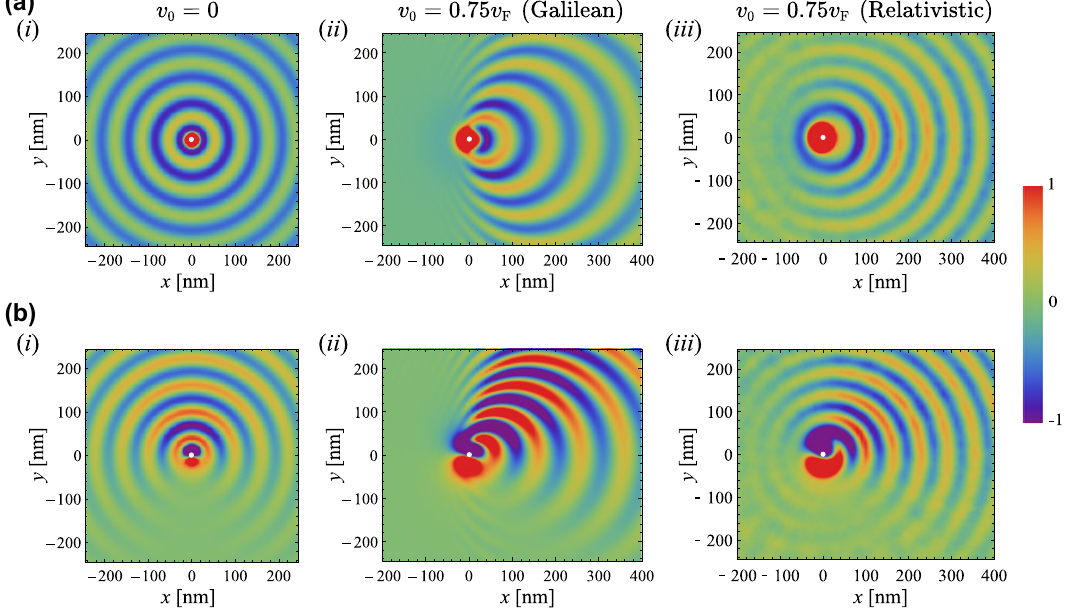
= 4. (a–b) Time r , s (in arbitrary unities)calculated on the surface of the graphene sheet for an electric dipole ( ) z ̂ z (C m); (b) Circularly polarized dipole with p ̂ y + i ̂ z = p = p (C e e,0 e e,0 = 0); (ii–iii) with a drift current bias ( 𝑣 = 0.75 𝑣 ), (ii) obtained using the Galilean Doppler shift model 0 0 F = 0.1 eV and 𝜏 = 1.7 c